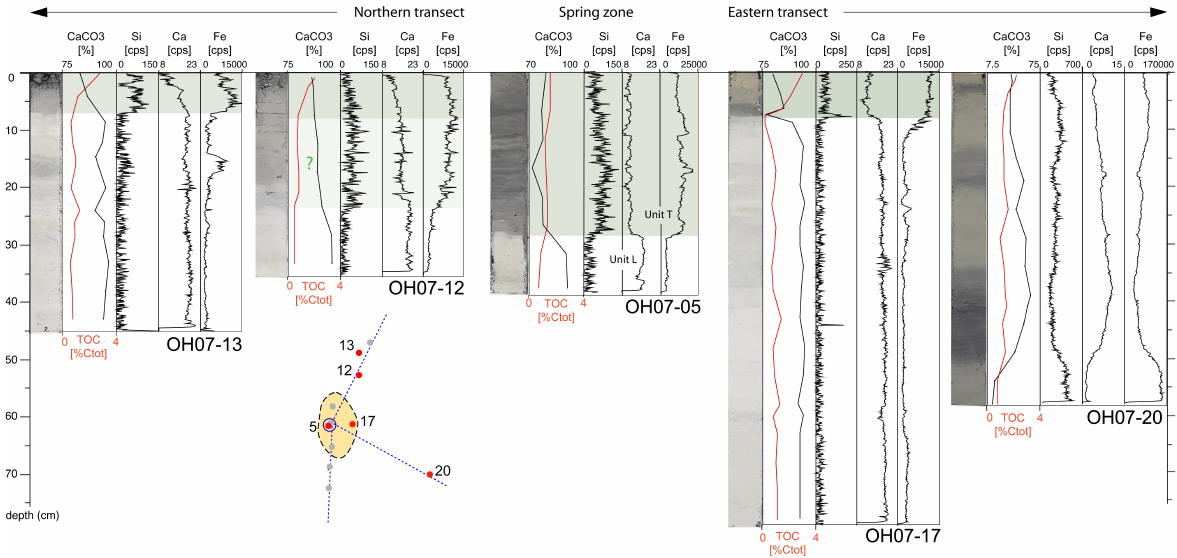
Fig. 7. Geochemical profiles (carbonate content, total organic carbon (TOC), XRF-counts of Si, Ca, and Fe) of cores 13, 12, 05, 17 and 20 together with core photographs. Green shades indicate Unit T. Note geochemical changes across Unit L-Unit T boundary. Unit assignment in core 12 is not straightforward as indicated by a question mark. Insert map shows location of displayed cores with red dots along the three transects (Fig.